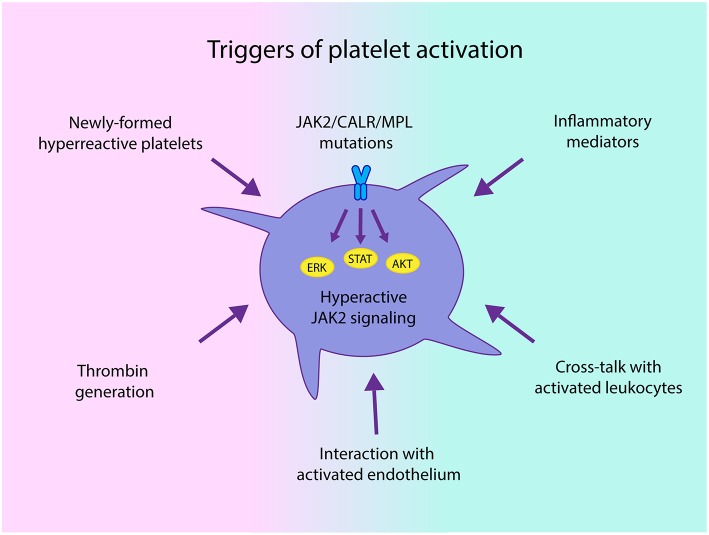
Triggers of platelet activation in chronic myeloproliferative neoplasms (MPN). Both intrinsic abnormalities derived from the MPN clone, such as JAK2-dependent hyperactivation of signaling pathways and hyperreactive newly-formed platelets, as well as extrinsic signals driven by enhanced interaction with activated leukocytes and endothelial cells and soluble mediators, including classical platelet agonists, such as thrombin generated by the hypercoagulable state and inflammatory factors may all converge to trigger platelet activation in MPN.